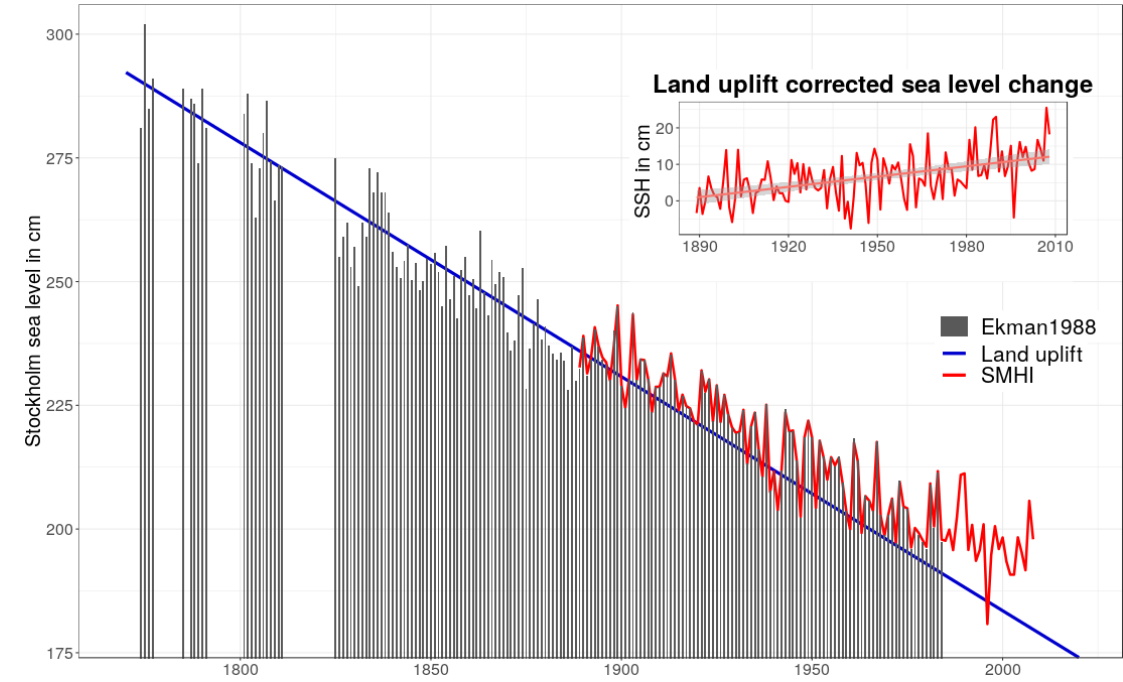
Figure 24. Annual mean sea level in Stockholm during 1774–2018. Grey bars show the historic time series from Ekman (1988, 2003). Red is the SMHI data (RH2000, 1889–2018), and blue is the trend computed for 1774–1884 (estimated land uplift of 4.9mmyr − 1 ) and extrapolated until 2018. The SMHI data were adjusted to the historical data, considering the mean difference during the overlapping time period, to make both time series comparable. The sea level rise of the SMHI data were corrected by estimated land uplift amounts of 1.13mmyr − 1 during 1889–2018. Data source: https://www.smhi.se (last access: 5 March 2022) at the Swedish Meteorological and Hydrological Institute, Norrköping,